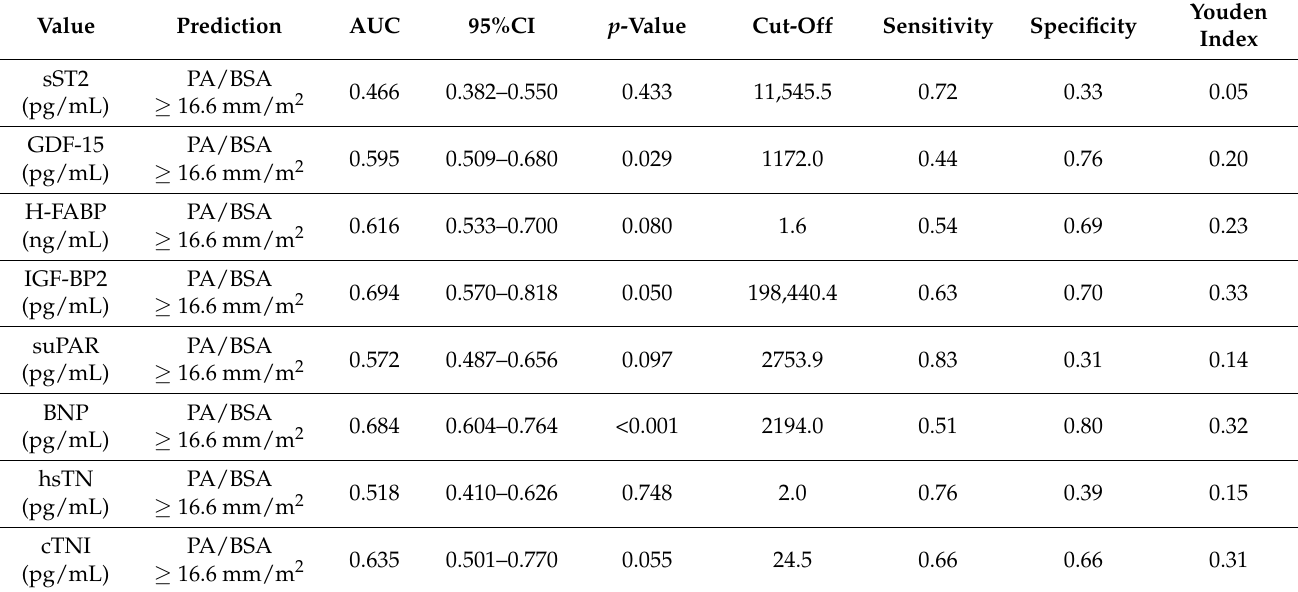
Table 4. Tabular overview of AUROC analyses of singular biomarkers for prediction of a PA/BSA value ≥ 16.6 mm/m 2 with concerning Youden Index, sensitivity, and specificity.